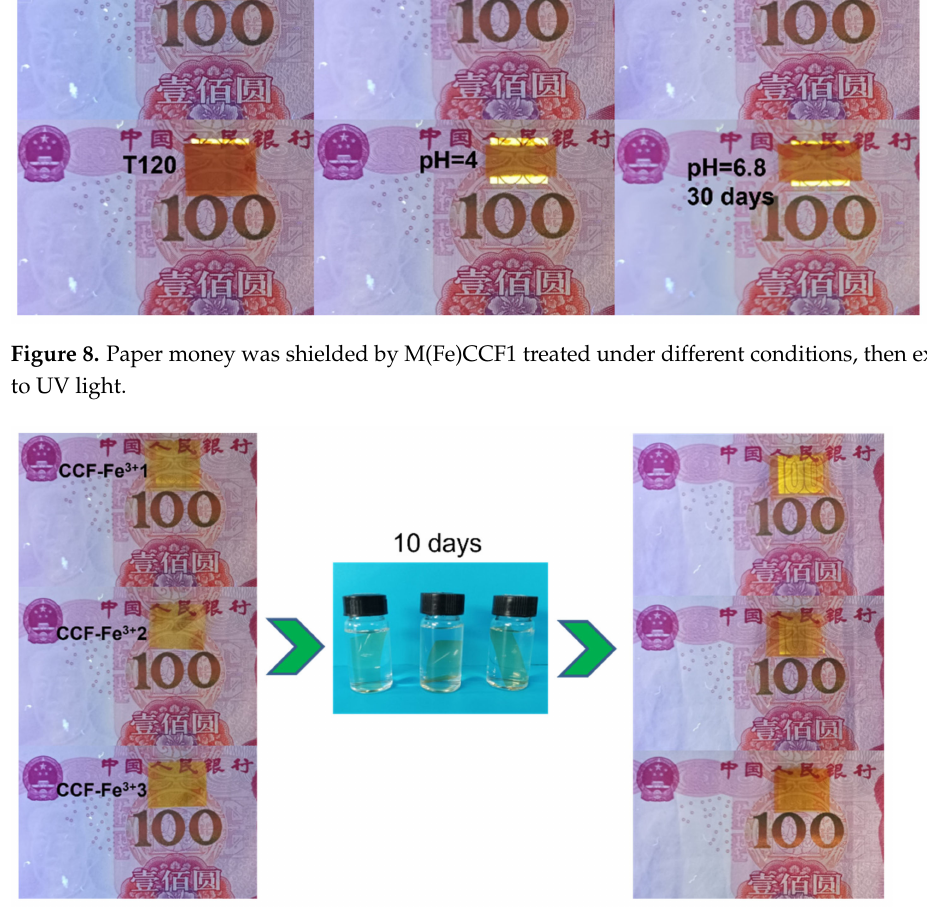
Figure 9. Effect of soaking in water (pH = 6.8) for 10 days on the UV blocking performance of CCF-Fe 3+